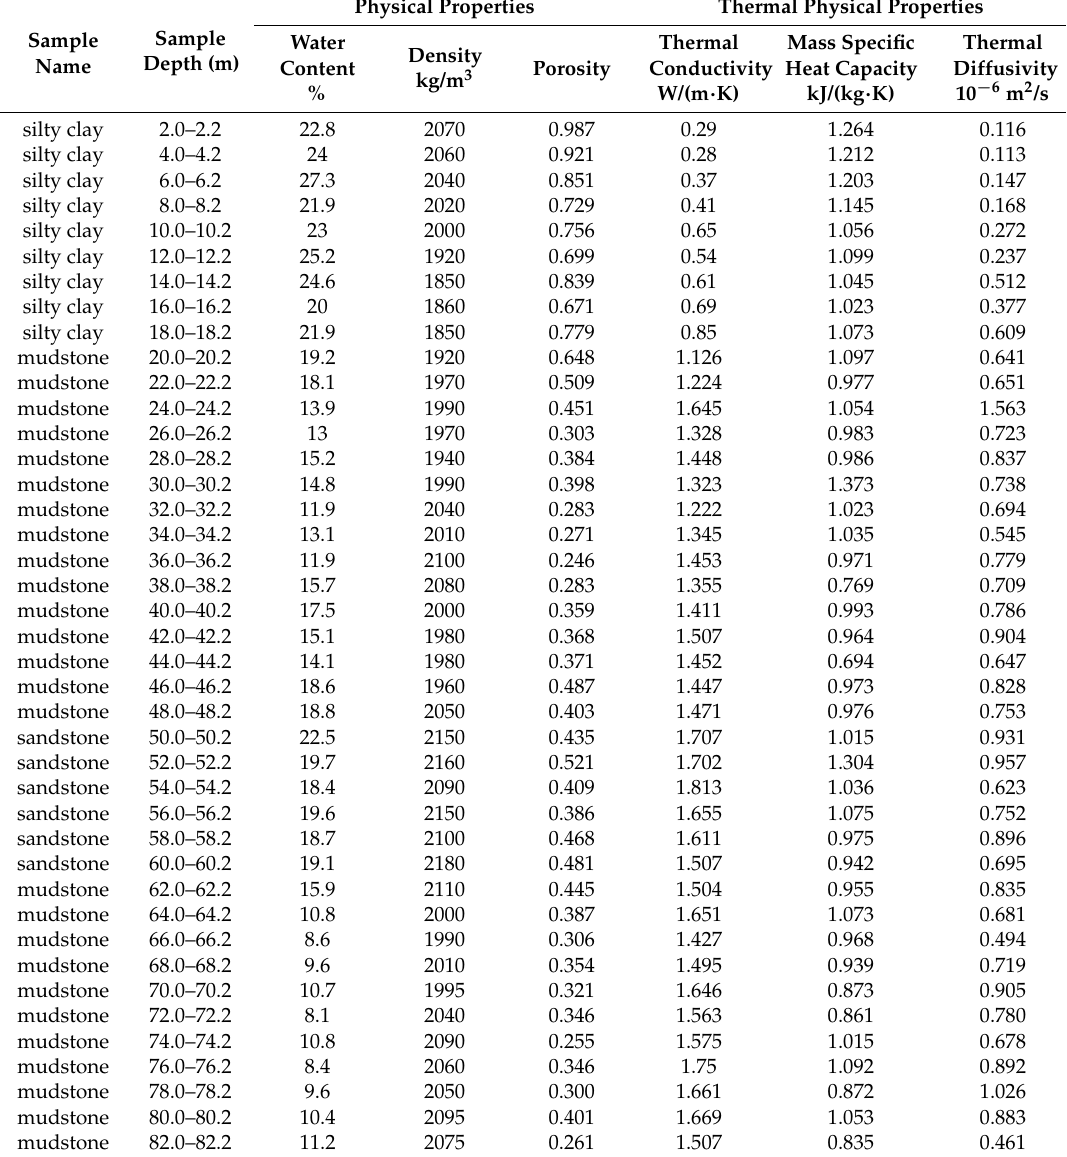
Table A1. Testing results of the laboratory